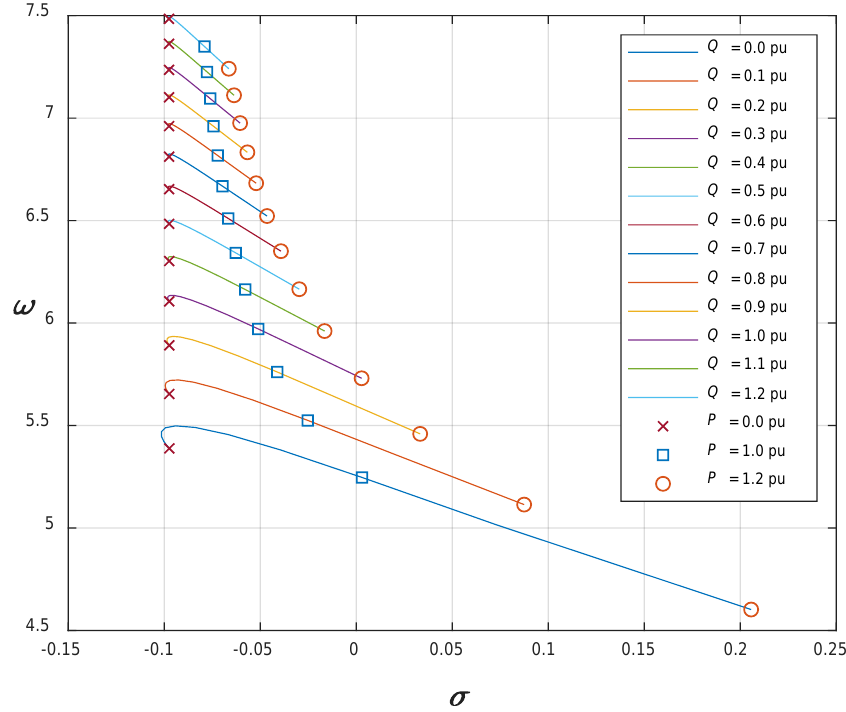
Figure 14. Eigenvalue loci of the local mode of 615-MVA hydro-type synchronous generator with AVR.